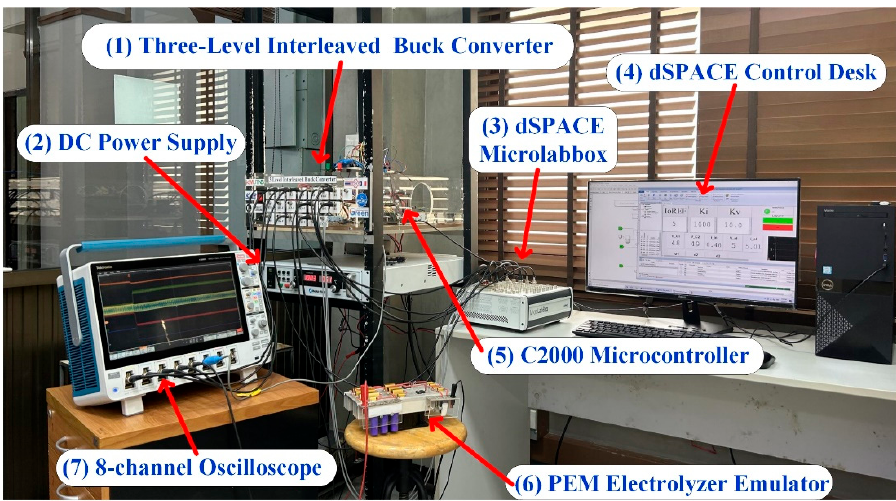
Figure 11. Developed experimental platform to validate the proposed fault diagnosis method and fault-tolerant control strategies.